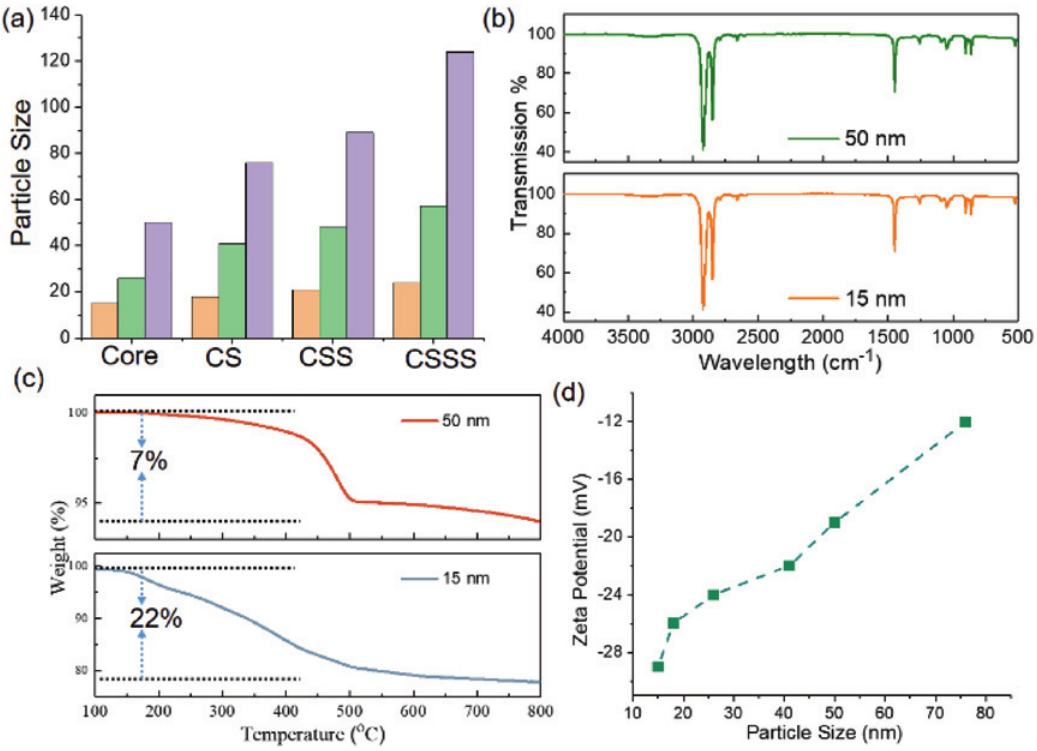
Figure 2: (a) Calculated mean particle size of the Core, CS, CSS and CSSS NCs shows in Figure 1e – p. FTIR spectra (b) and TGA curves (c) of the NCs with different particle sizes. (d) Dependence of Zeta potential versus particle